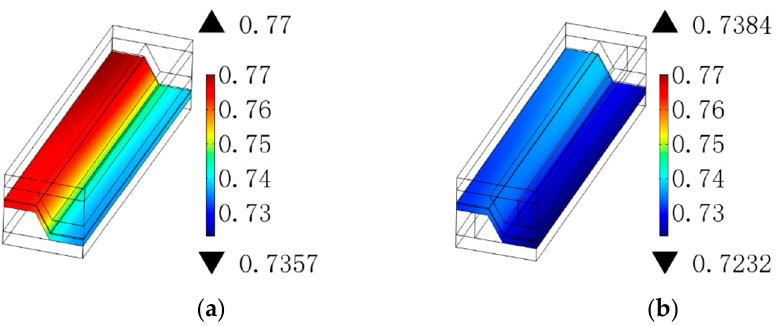
Figure 4 . Cathode potential distribution: ( a ) conventional design: ( b ) vertical rib design (unit: V).